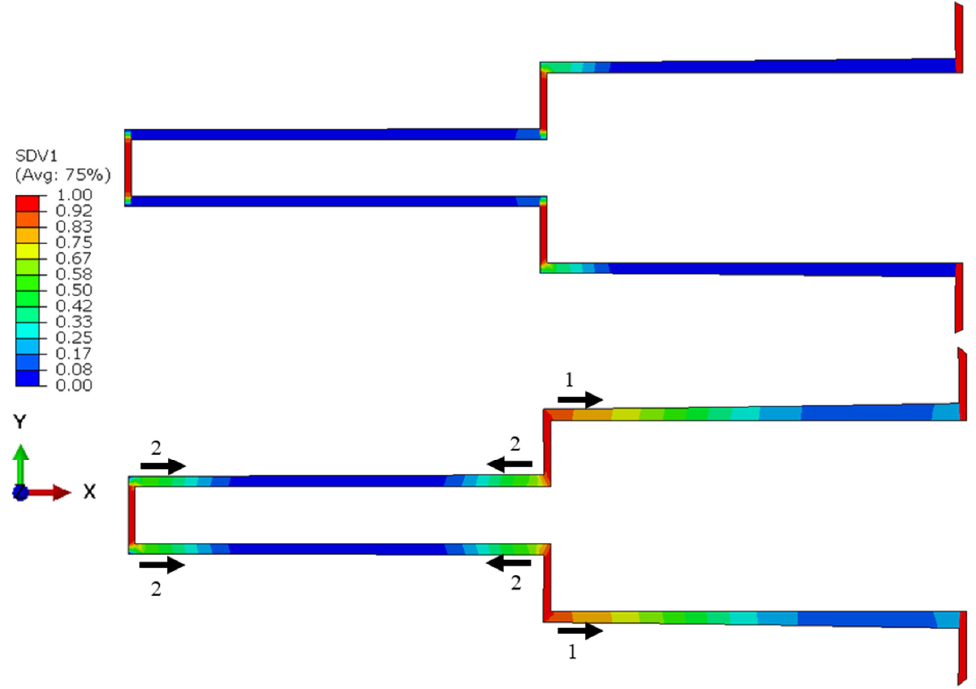
Figure 8. Distribution of the fatigue damage in the adhesive layer with the crack propagation direction and its sequence for the double ‐ step ‐ lap joint subjected to 8 kN tensile loading at N f /3 ( top ) and 2 N f /3 ( bottom ). Numbers 1 and 2 in the figure represent the sequence of the crack propagation.